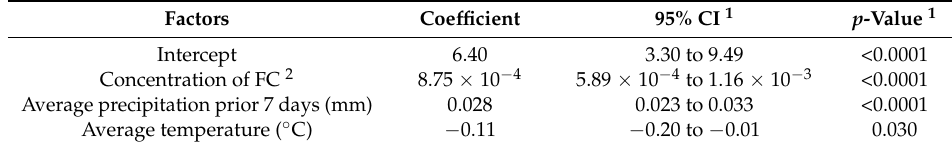
Table 3. Mixed-effects negative binomial regression model for factors associated with the concentration of E. coli in pooled oysters from Phang Nga Bay, southern Thailand, March 2016 to February 2017. Factors Coefficient 95% CI 1 p -Value 1 Intercept Average precipitation prior 7 days (mm) Concentration of FC 2